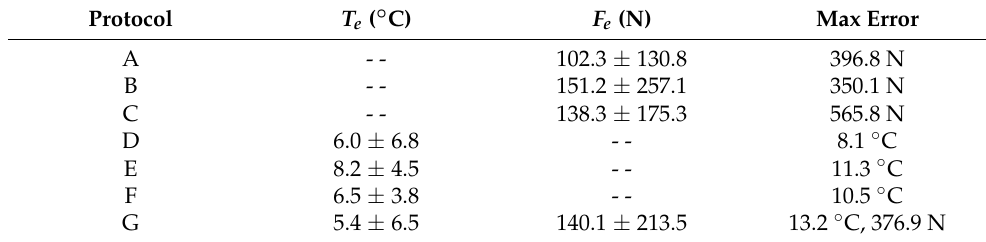
Table 1. Average tracking results for Protocols A–G.